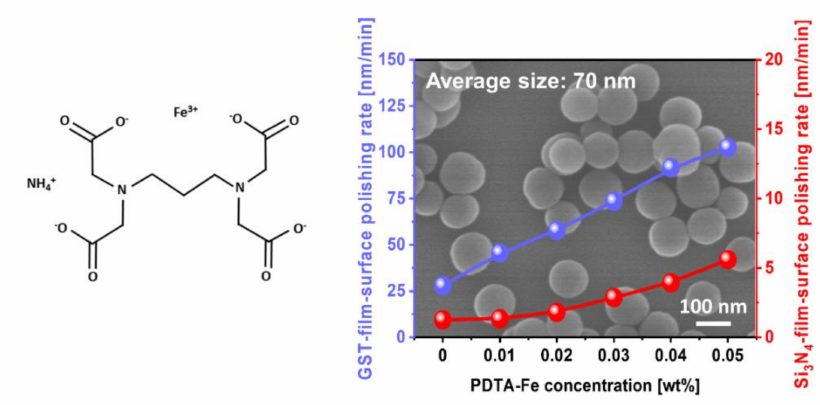
Figure 2. Dependency of Ge 1 Se 4 Te 5 -, and Si 3 N 4 films polishing-rate on ferric–ionic catalyst (i.e., PDTA–Fe) concentration. PDTA–Fe is decomposed of Fe 3+ , NH 4 + , and [C 11 H 14 N 2 O 8 ] 4 − in the acid (i.e., pH 2.0) slurry. The average diameter of colloidal silica abrasives was 70 nm, as shown in inset SEM